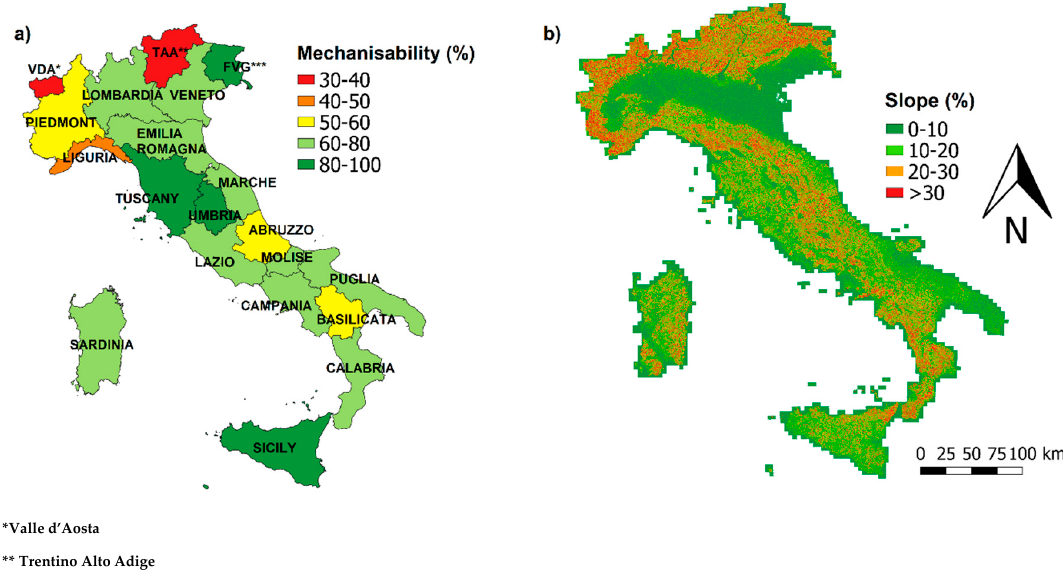
Figure 6. Classification of the level of mechanisability ( l.m .) of Italian regions ( a ) compared to the map of the mean slope of the Country ( b ).